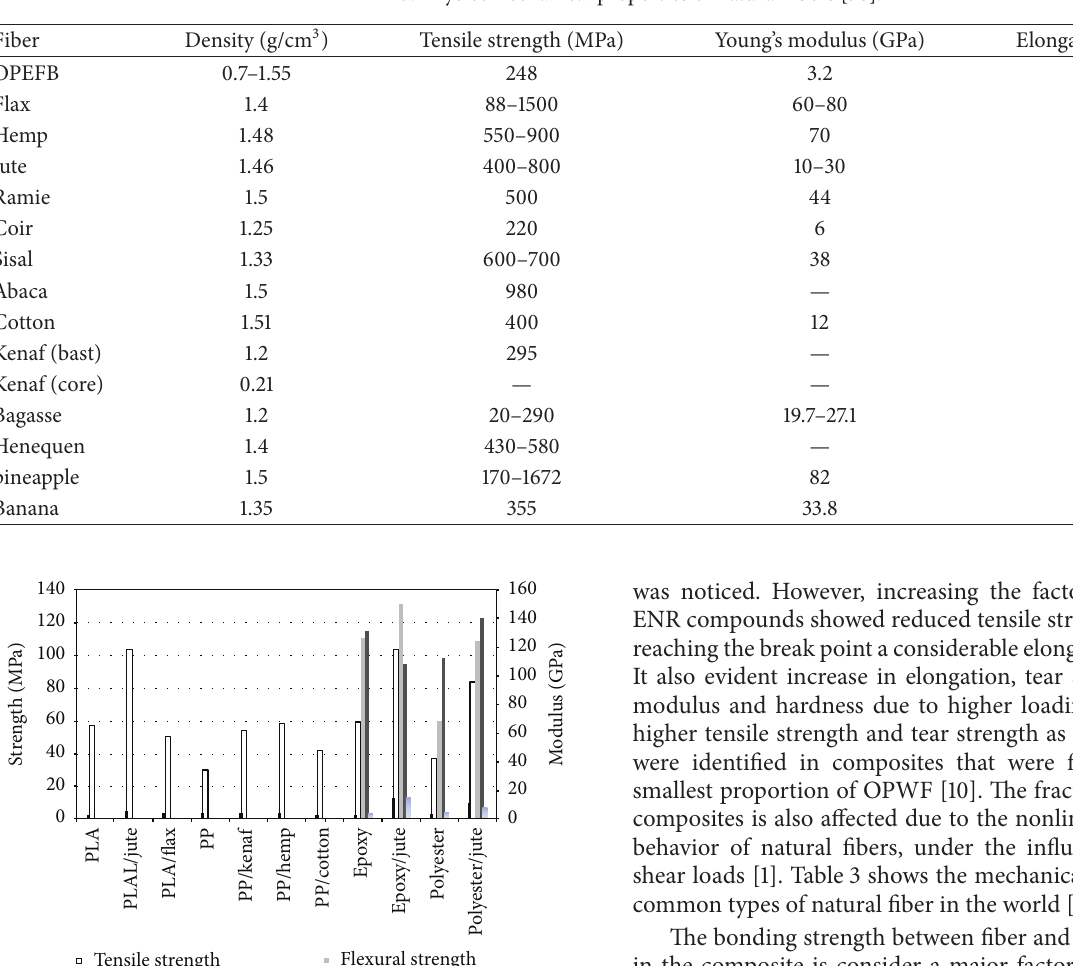
Table 3: Physicomechanical properties of natural fibers [38].